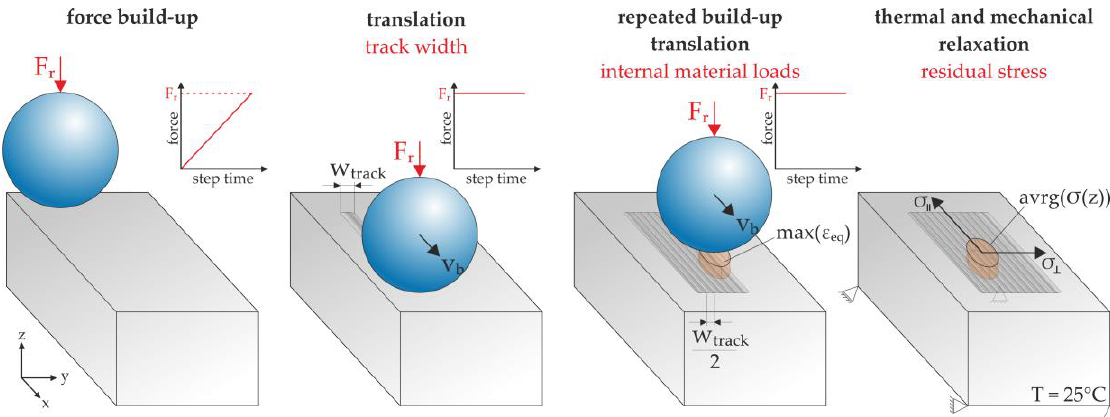
Figure 9. Kinematics sequence in the deep rolling simulation and illustration of the derived parameters for further analyses (red font).